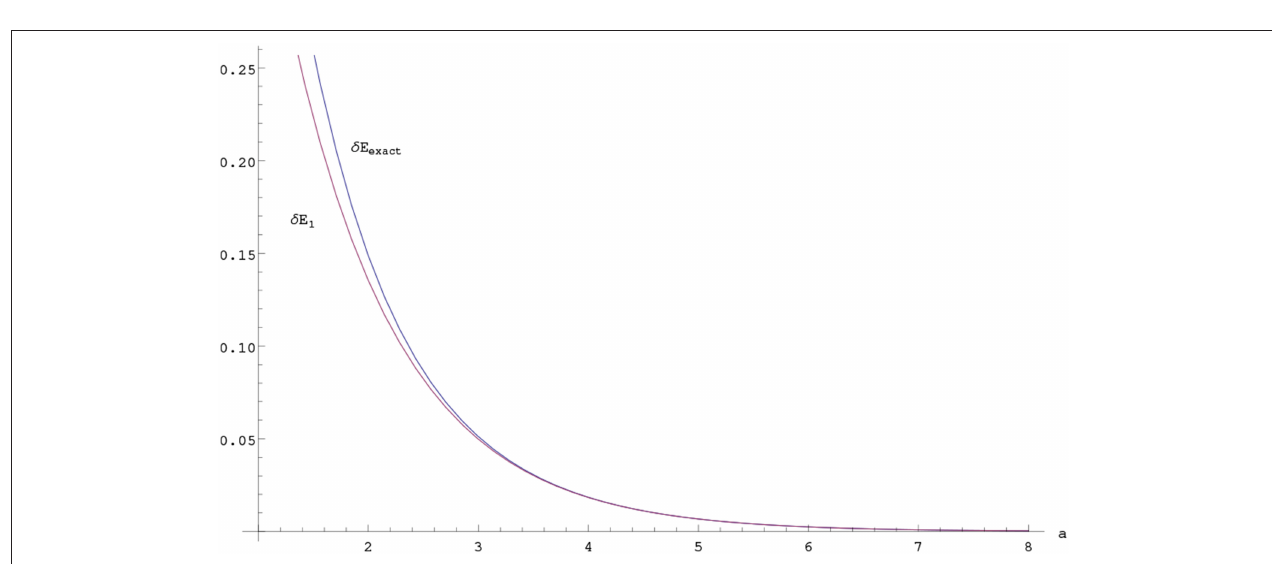
1 unit in two dimensions. =